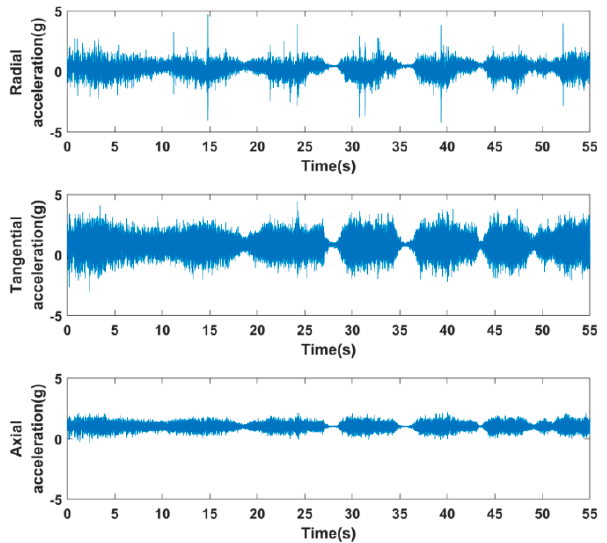
Figure 5. Timing chart of drilling signals intercepted from 4700 m to 4720 m.